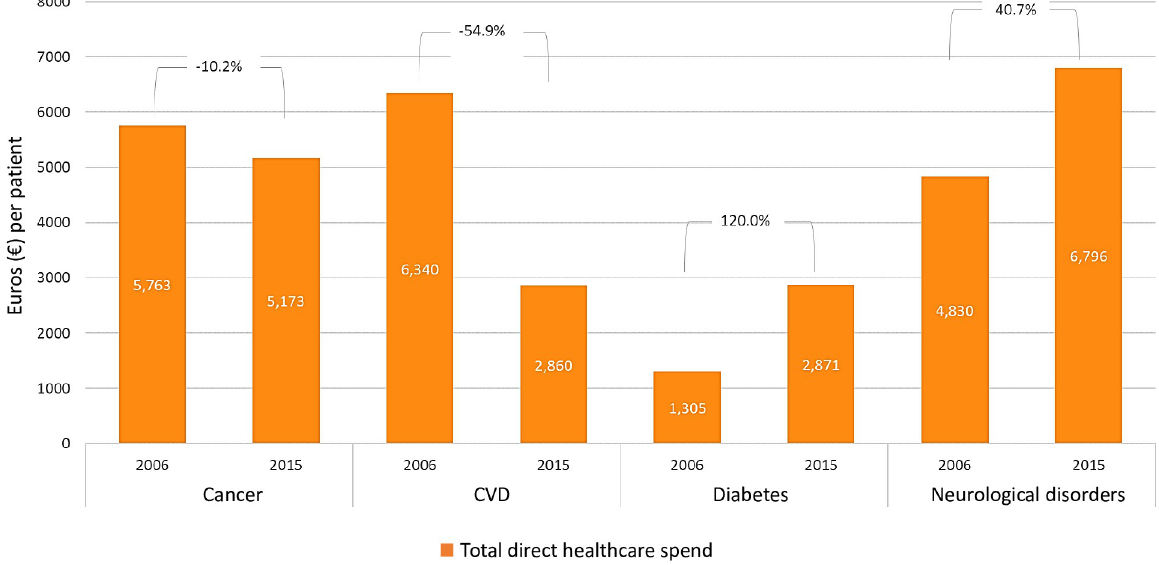
Fig 4. Total direct healthcare expenditure per patient, by disease (2006–2015). Percentage estimates denote percent change in total direct healthcare expenditure per patient between 2006 and 2015 in each disease